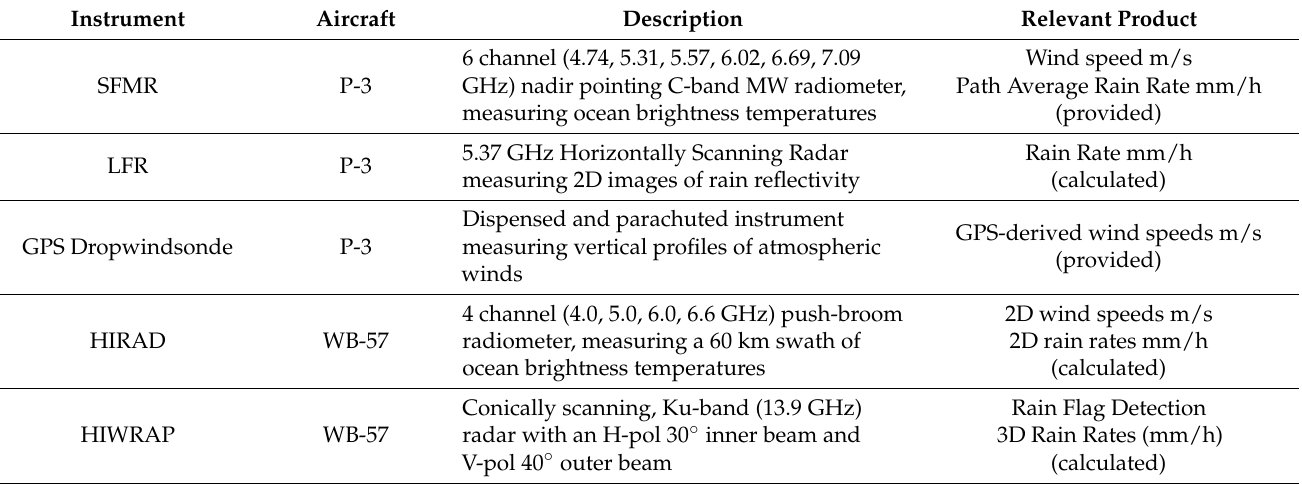
Table 1. Available instruments and